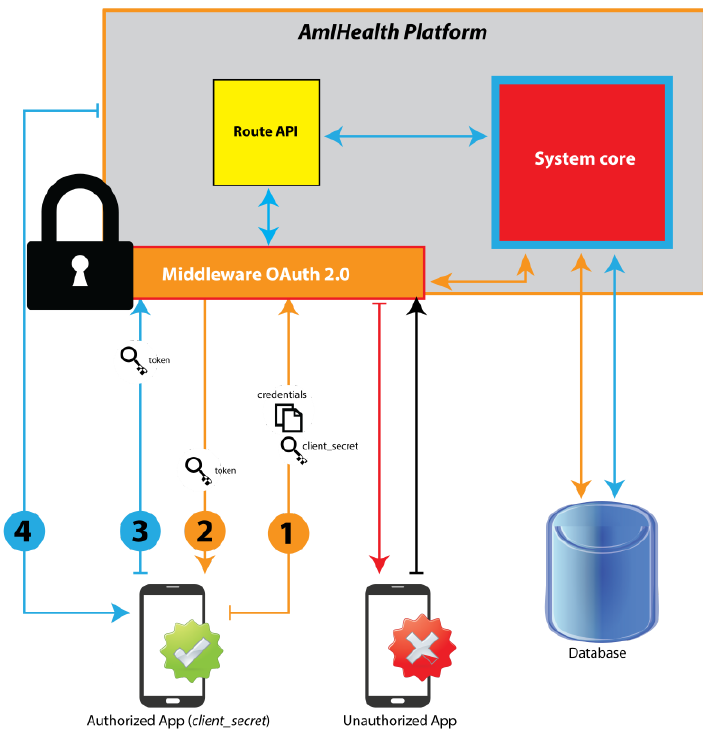
Figure 2. Operation of the OAuth 2.0 middleware.